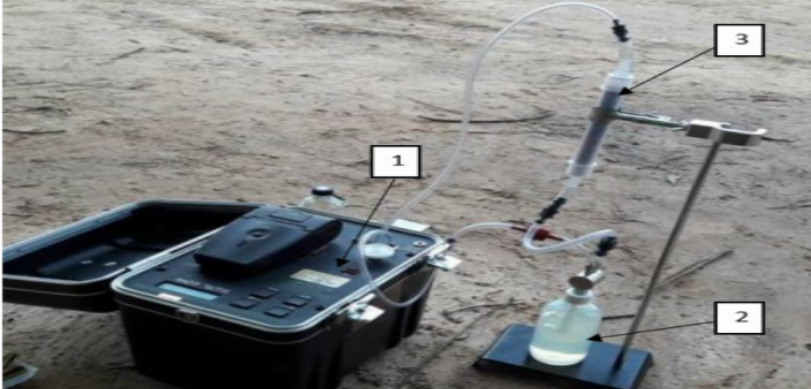
Figure 2. RAD7 equipment for the radon measurements in the water samples: (1) RAD7 detector; (2) 250 mL water vial with aerator; (3) tube of desiccant.